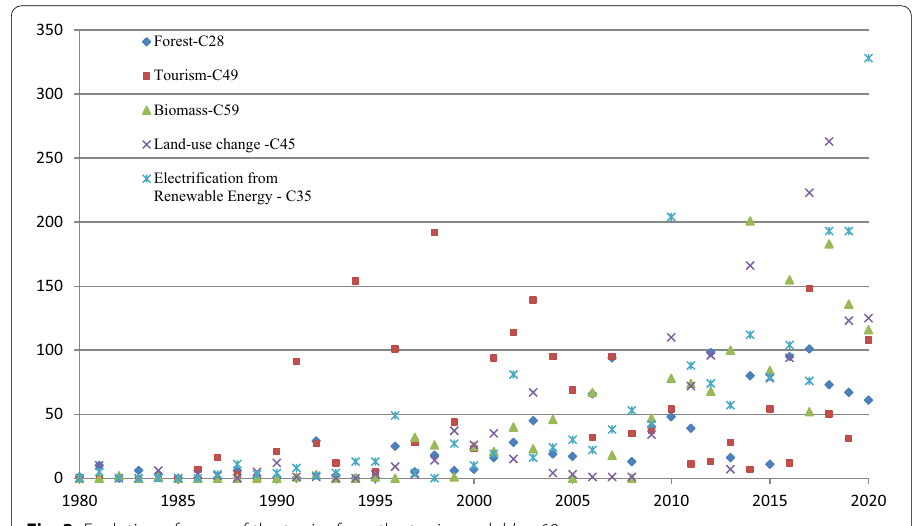
Fig. 3 Evolution of some of the topics from the topic model k